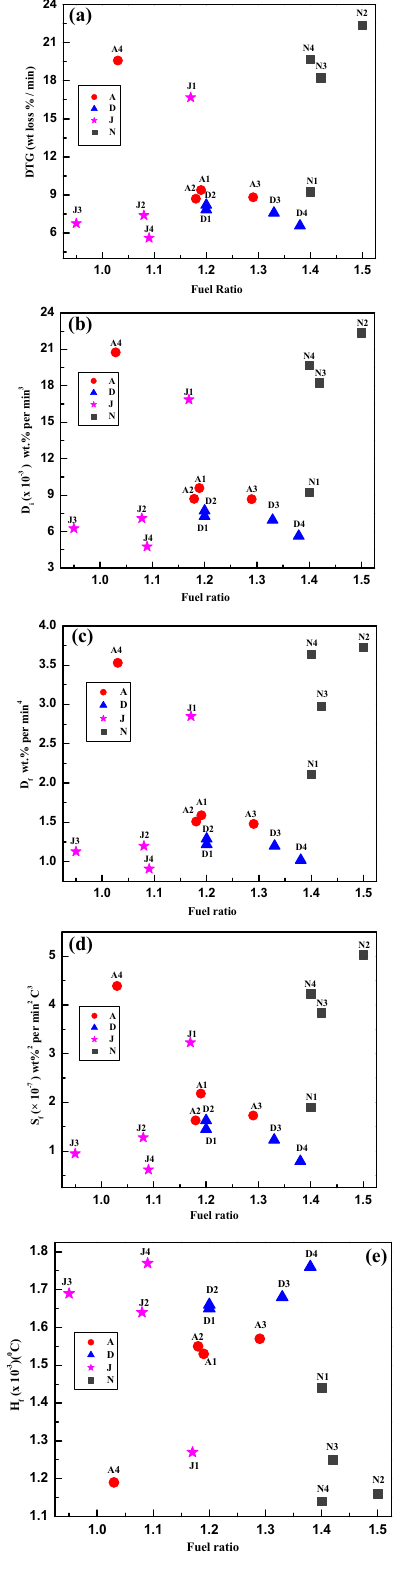
Fig. 5 Variation of combustion parameters: a DTG max , b D i , c D f , d S f , e H f with fuel ratio for all the